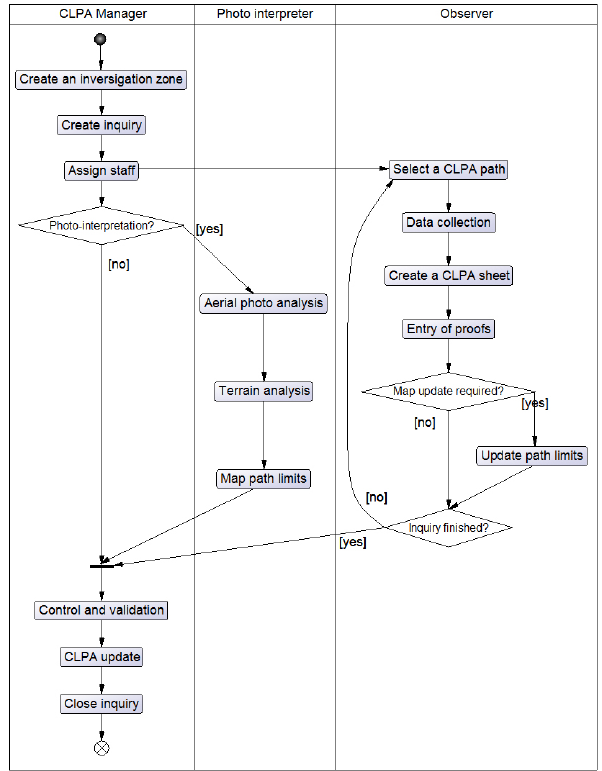
Figure 4. Activity diagram describing the process of data acquisi- tion during a CLPA